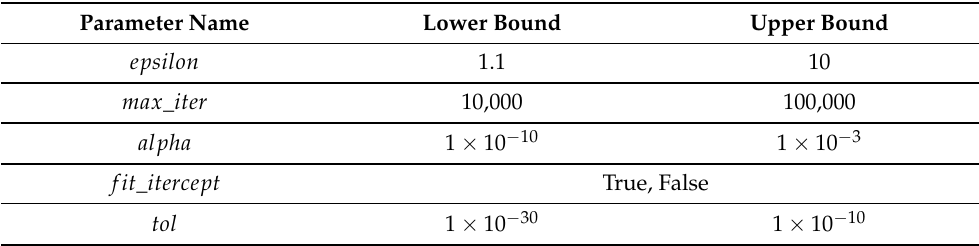
Table 6. An overview of the used hyper-parameter range for Huber Regression Algorithm.